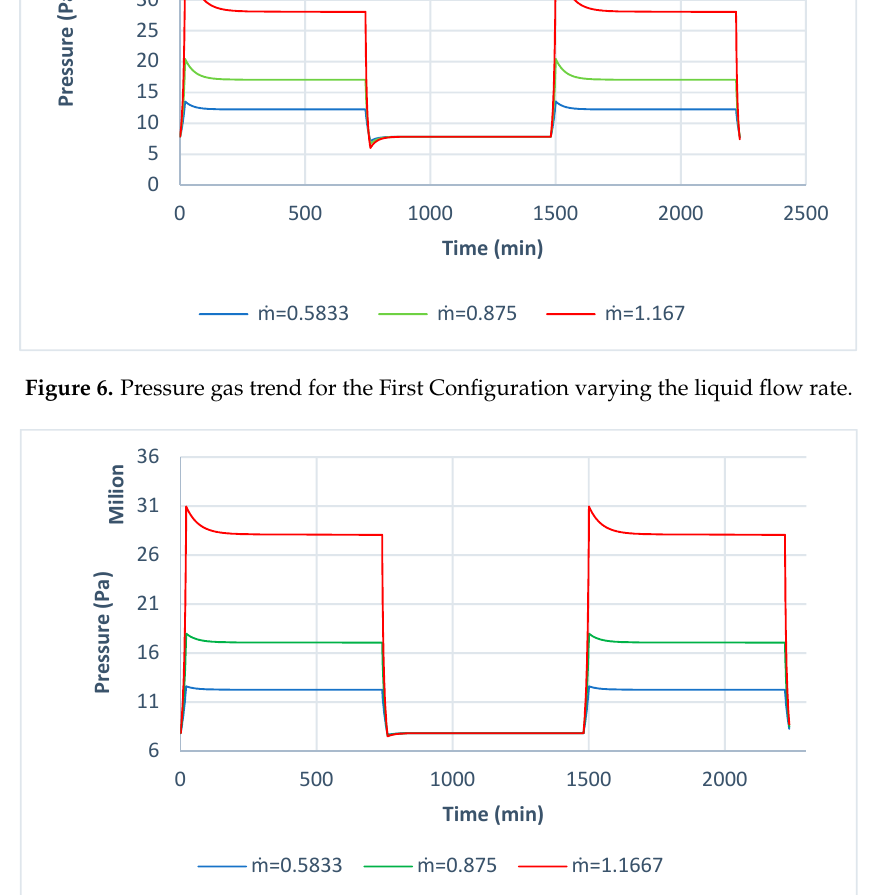
Figure 7. Pressure gas trend for the Second Configuration varying the liquid flow rate.